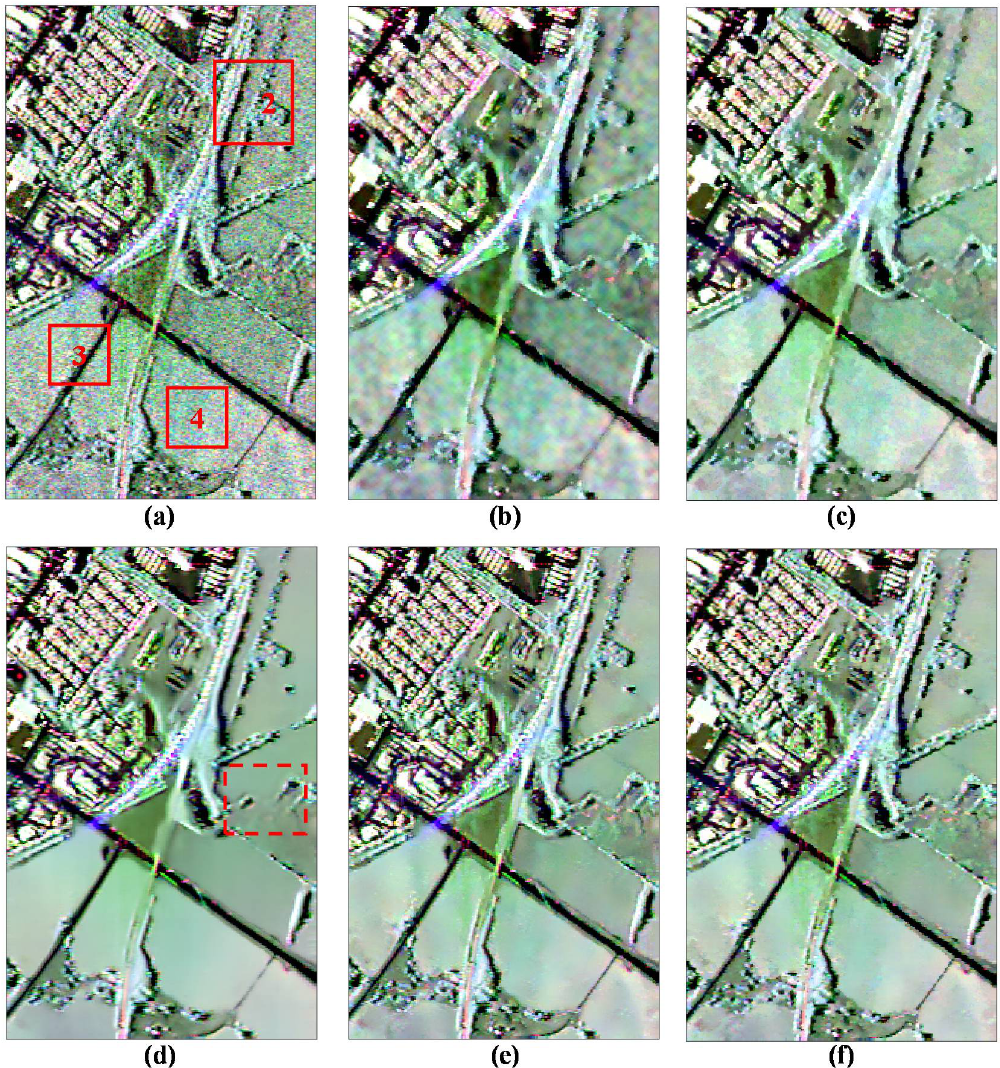
Figure 7. Denoising results of different filtering methods using SAR580-Convair C-band data. ( a ) Original data. ( b ) Refined Lee filter. ( c ) IDAN filter. ( d ) Pretest filter. ( e ) NL-SAR filter. ( f ) The proposed ANLM filter.